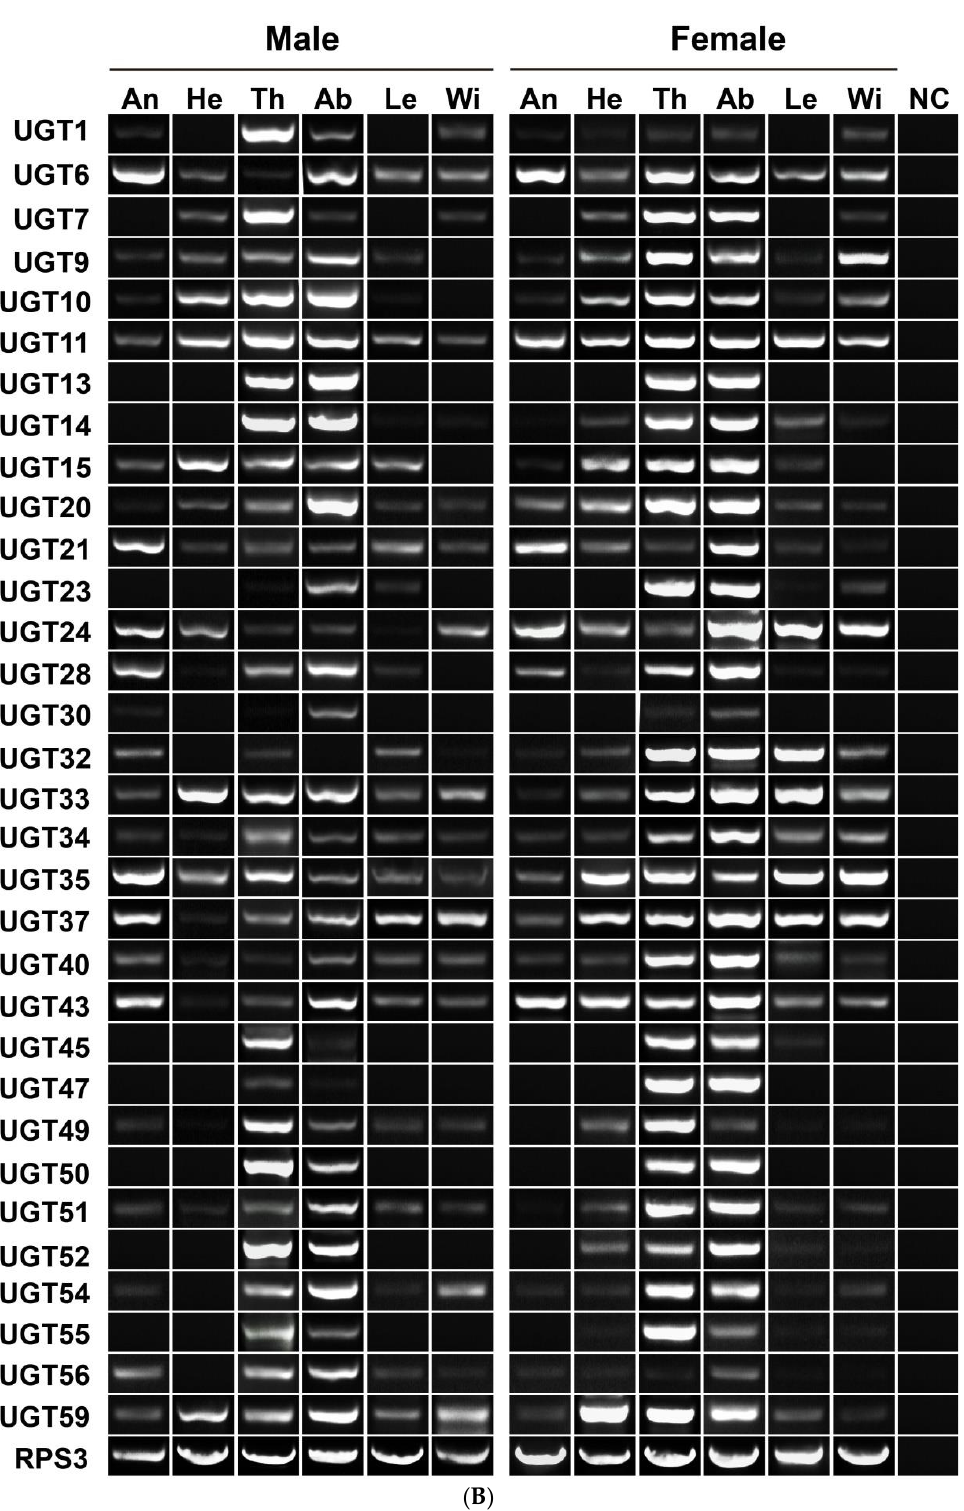
Figure 3. Expression pattern of candidate UGT genes in different tissues of P. antennata . ( A ) Expression patterns of PantUGT genes with FPKM values. ( B ) Expression patterns of PantUGT genes with PCR assays. PantRPS3 was used as the reference gene to detect the quality and quantity of cDNA templates. An: antennae; He: heads without antennae; Th: thoraxes; Ab: abdomens; Le: legs; Wi: wings; NC: negative control using sterile water as the template.